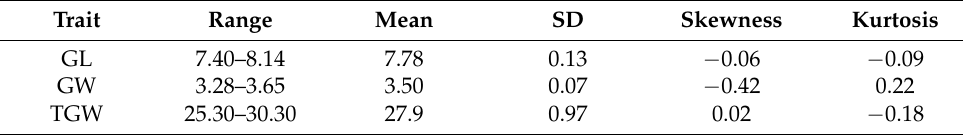
Figure 4. Frequency distributions of GL, GW, and TGW in the BC 9 F 3 population. Table 1. Phenotypic performance of GL, GW, and TGW in the BC 9 F 3 population.